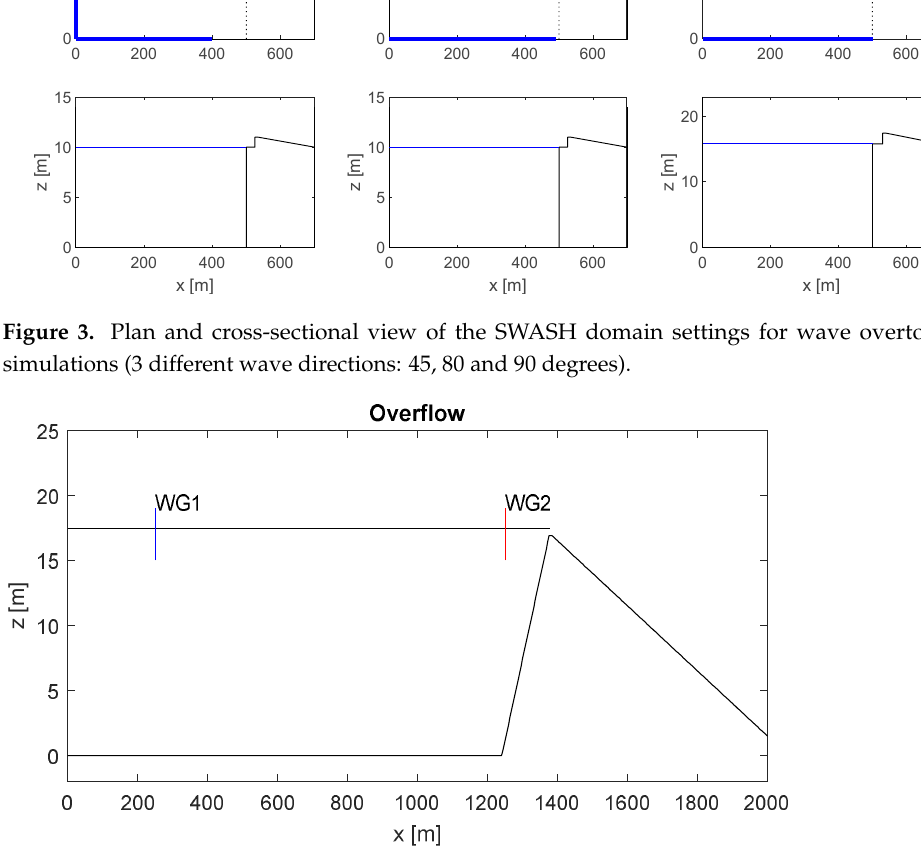
Figure 4. Cross-sectional view of the SWASH model domain setting applied to the overflow simulation (the straight line represents the initial water level).